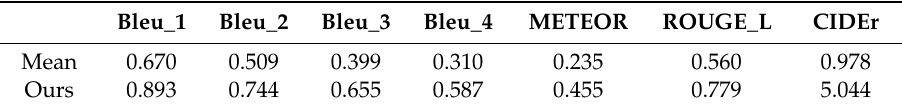
Table 4. Comparing evaluation metrics.